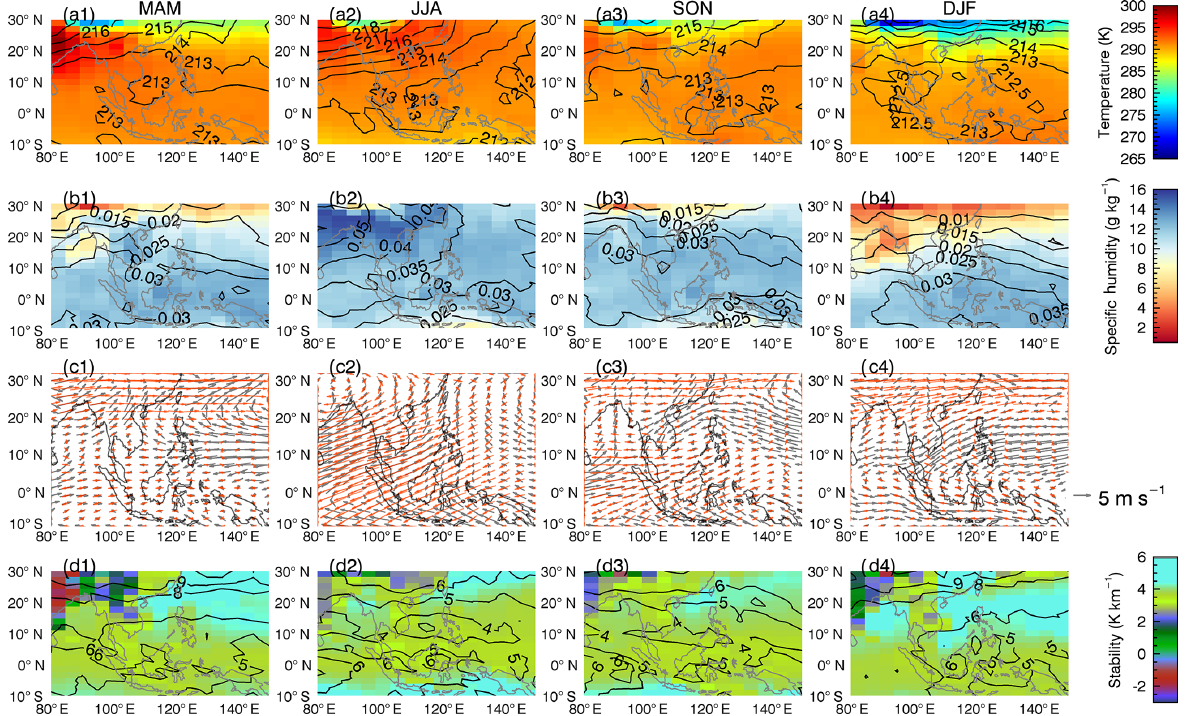
Figure 2. (a1–a4) Temperature, (b1–b4) specific humidity, (c1–c4) wind field, and (d1–d4) static stability derived from the ECMWF-AUX data; shade for 850hPa, contour for 180hPa, grey vectors for wind field at 850hPa, and red vectors for